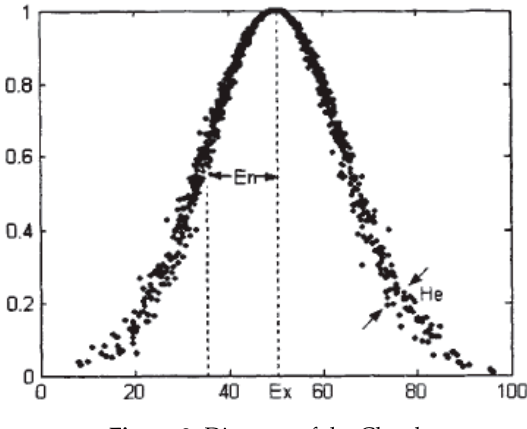
Figure 2. Diagram of the Cloud.